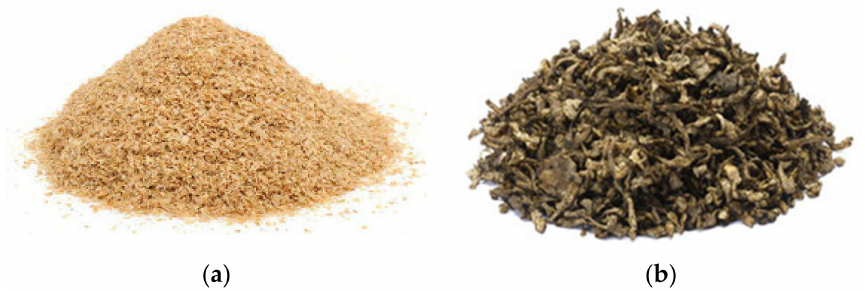
( a ) wheat bran and ( b ) beet pulp.